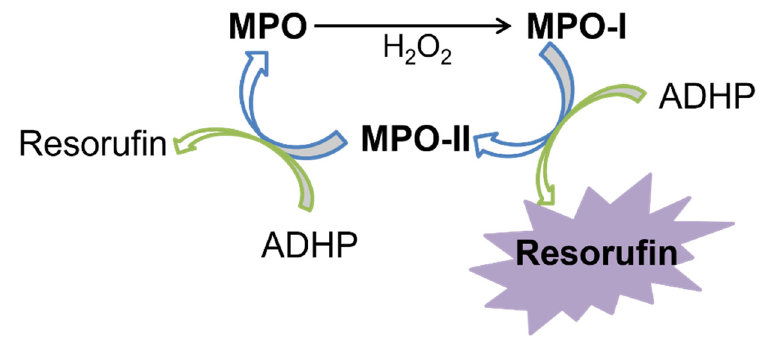
Figure 1. Enzyme reaction scheme of myeloperoxidase.